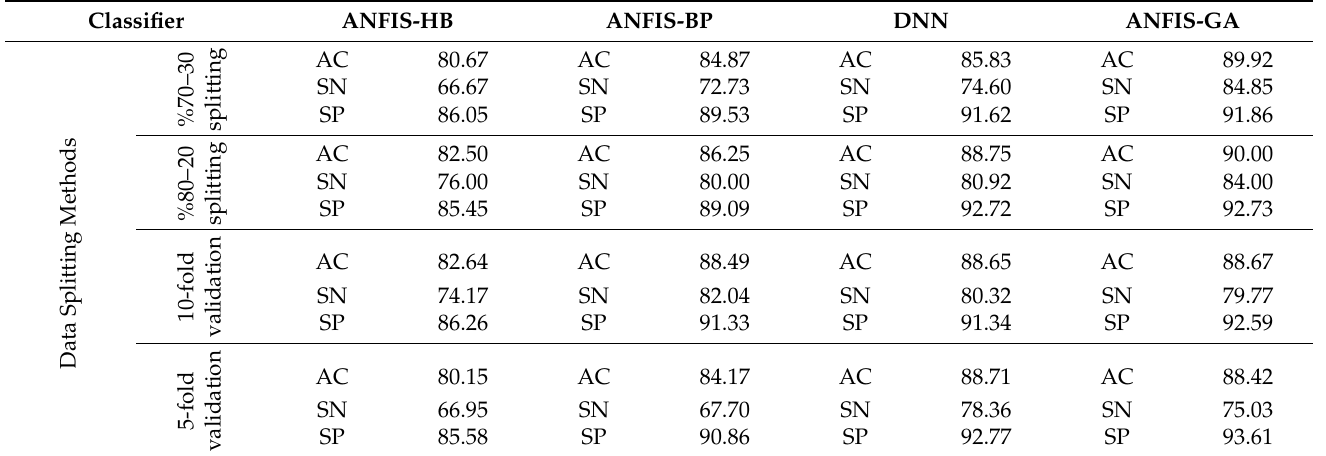
Table 3. The performance of the proposed method compared to conventional methods for 13